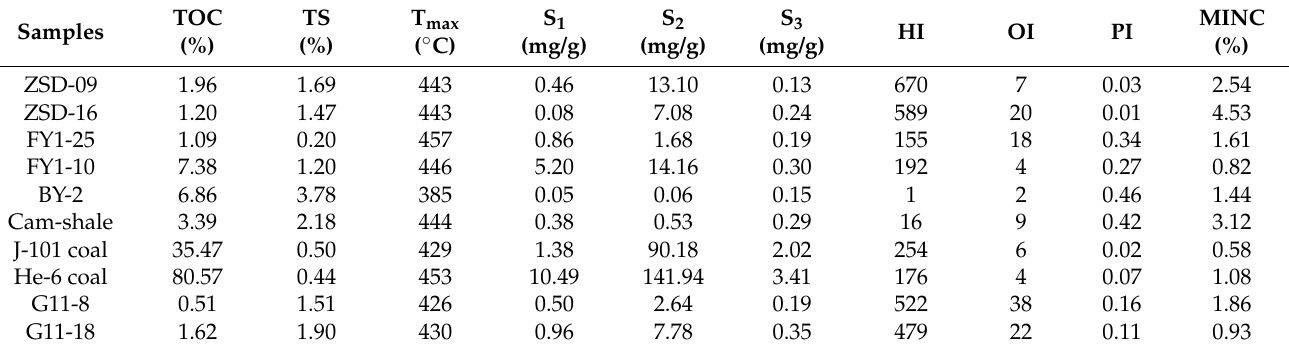
Table 1. Total organic carbon (TOC) and pyrolysis data for source rock